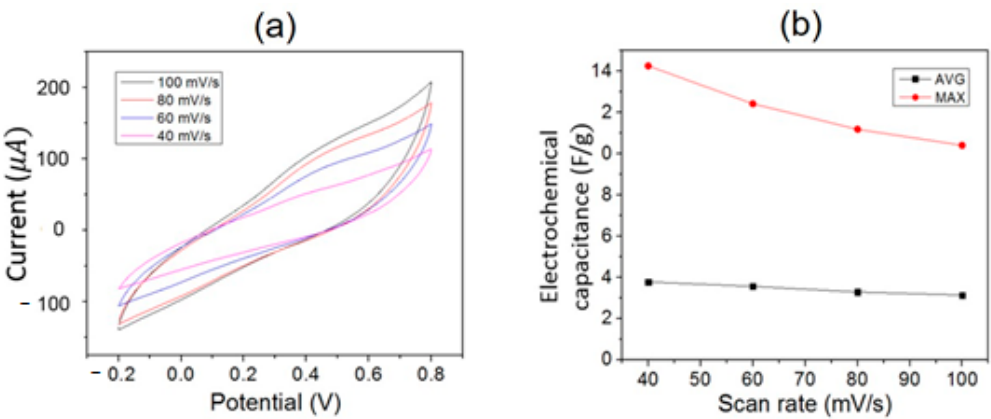
Figure 5. Electrochemical measurements for 100 nm CoSiB TFMG: ( a ) electrical current versus potential at different scan rates. ( b ) Average (AVG) and maximum (MAX) values of capacitance versus voltage scan rate, extracted from ( a ).